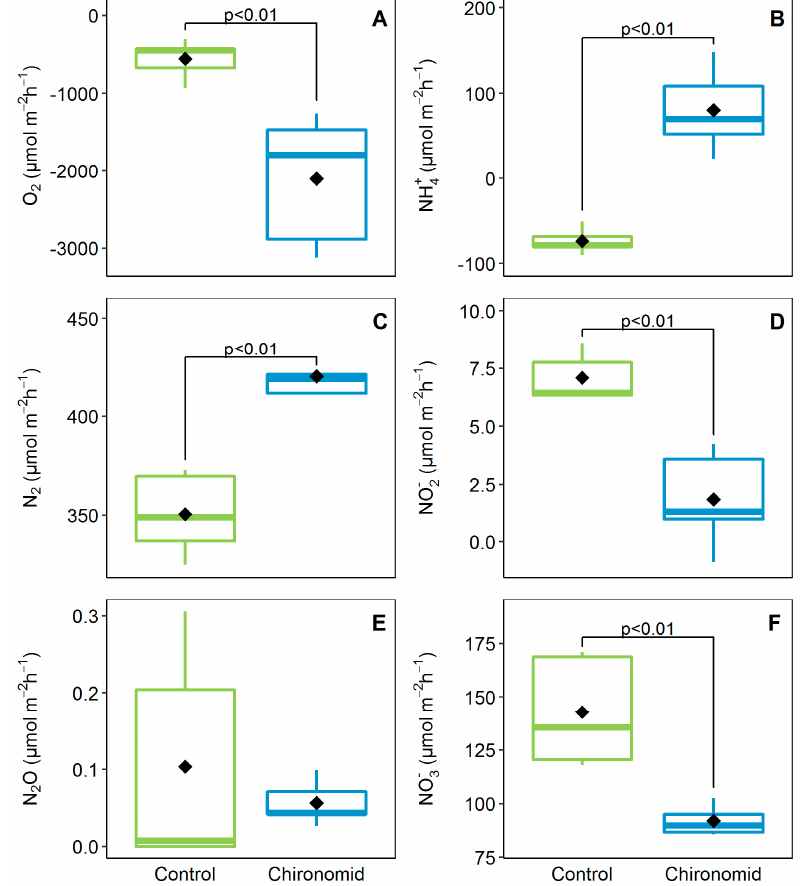
Figure 2. Benthic net fluxes of dissolved oxygen ( A ), ammonium ( B ), dinitrogen ( C ), nitrite ( D ), nitrous oxide ( E ) and nitrate ( F ) at the sediment–water interface measured in the control and the chironomid larvae microcosms. Each boxplot (n = 5) represents the data range (whiskers), upper and lower quartiles (edges), the median (horizontal line), and the mean (black diamond).